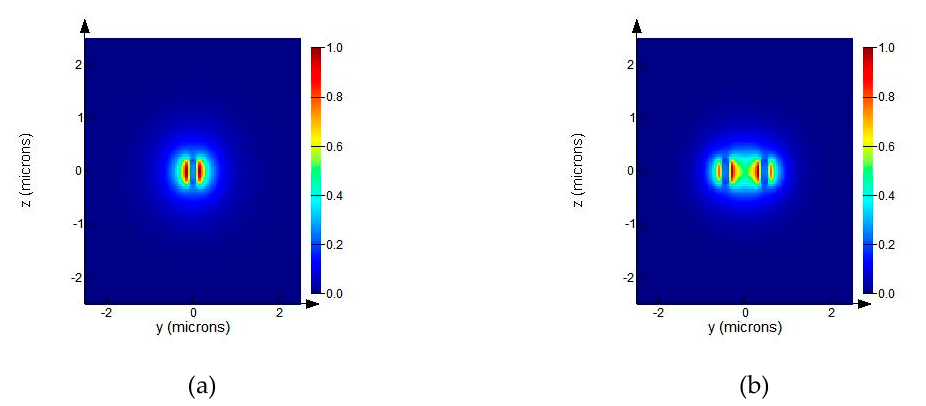
Figure 6. Modal distribution at the facet of ( a ) a single taper and ( b ) two bilateral tapers.